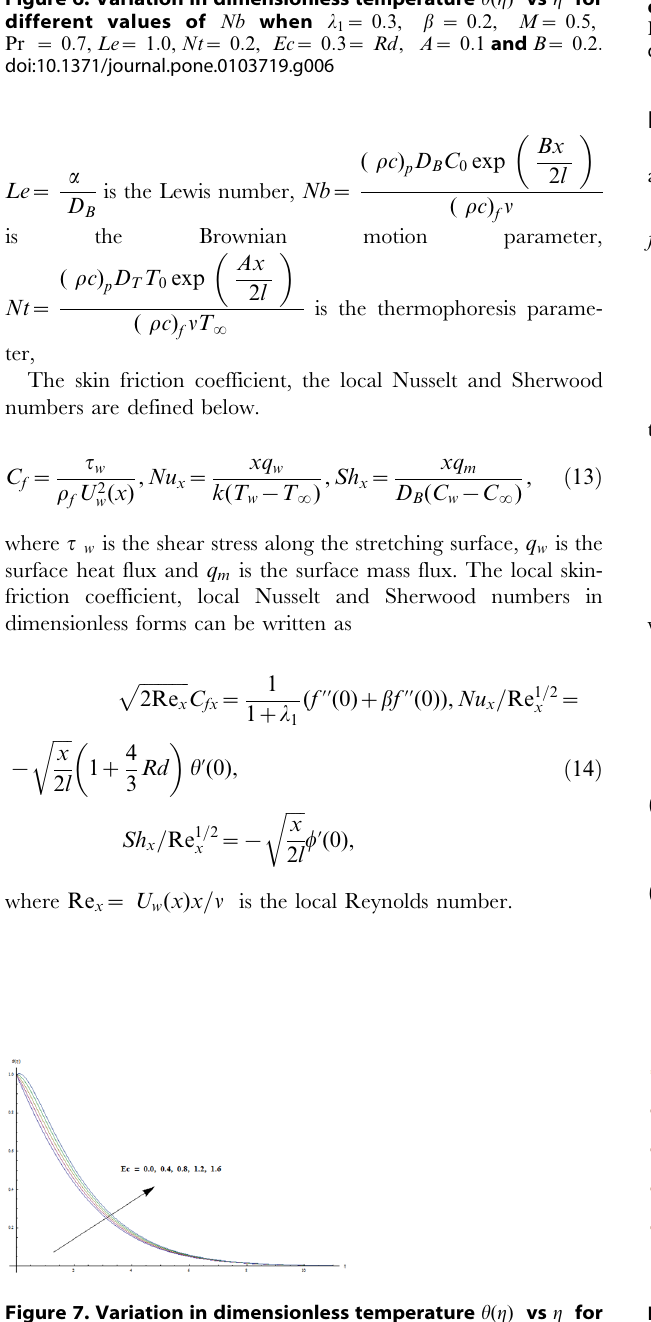
Figure 6. Variation in dimensionless temperature h ( g ) vs g for different values of Nb when l 1 ~ 0 : 3, b ~ 0 : 2, M ~ 0 :